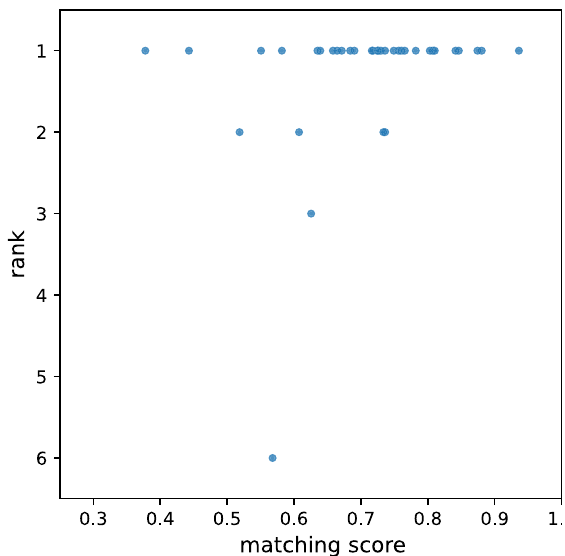
Figure 4. Relationship between matching score and rank for actual matching molecules of query